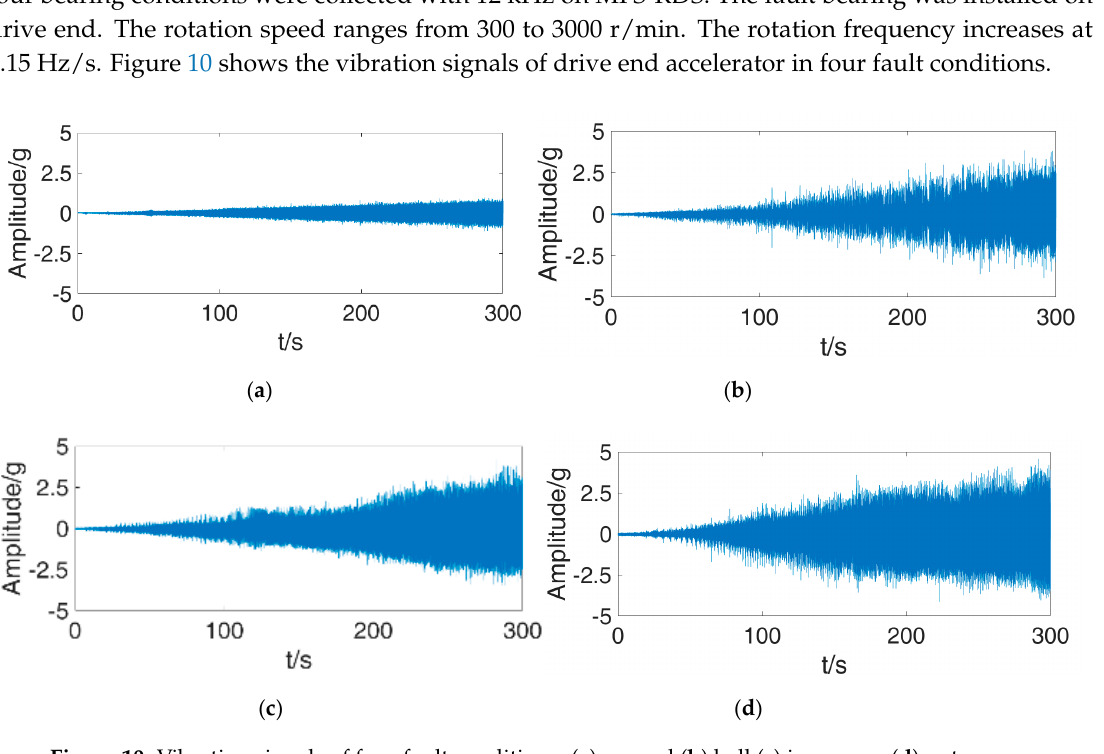
Table 9. Fault diagnosis result using other proposed CNN-based methods.